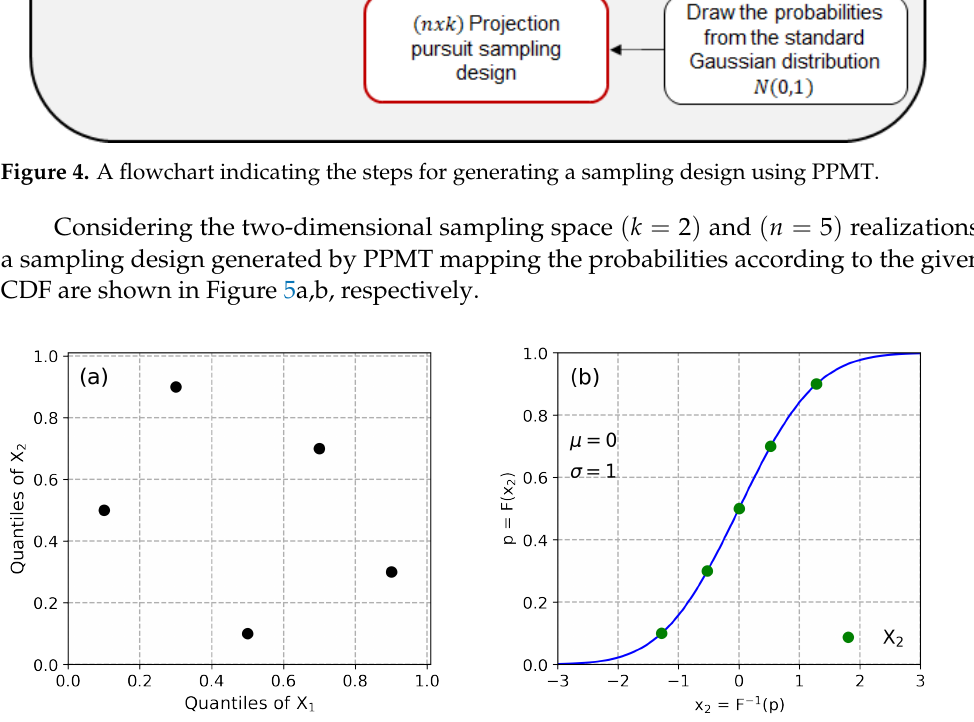
Figure 5. ( a ) A sampling design with n = 5 realizations generated by PPMT in a two-dimensional sampling space where the random variables are independent, ( b ) Mapping the quantiles according to the standard Gaussian distribution using the inverse transform